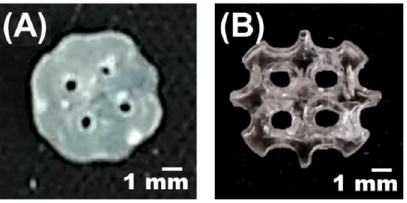
Figure 3. Comparison of the different HEMA addition amount with the same porosity and pore size of the scaffolds. The weight of HEMA is ( A ) 0.1 and ( B ) 0.3 times the weight of the PU/TPU mixture.